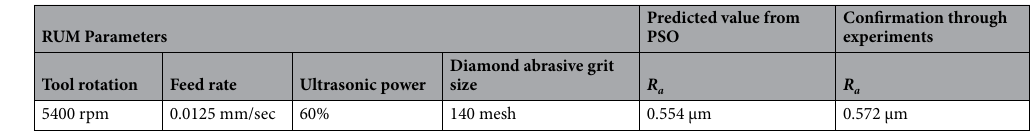
Table 9. Optimum values of RUM conditions for R a .